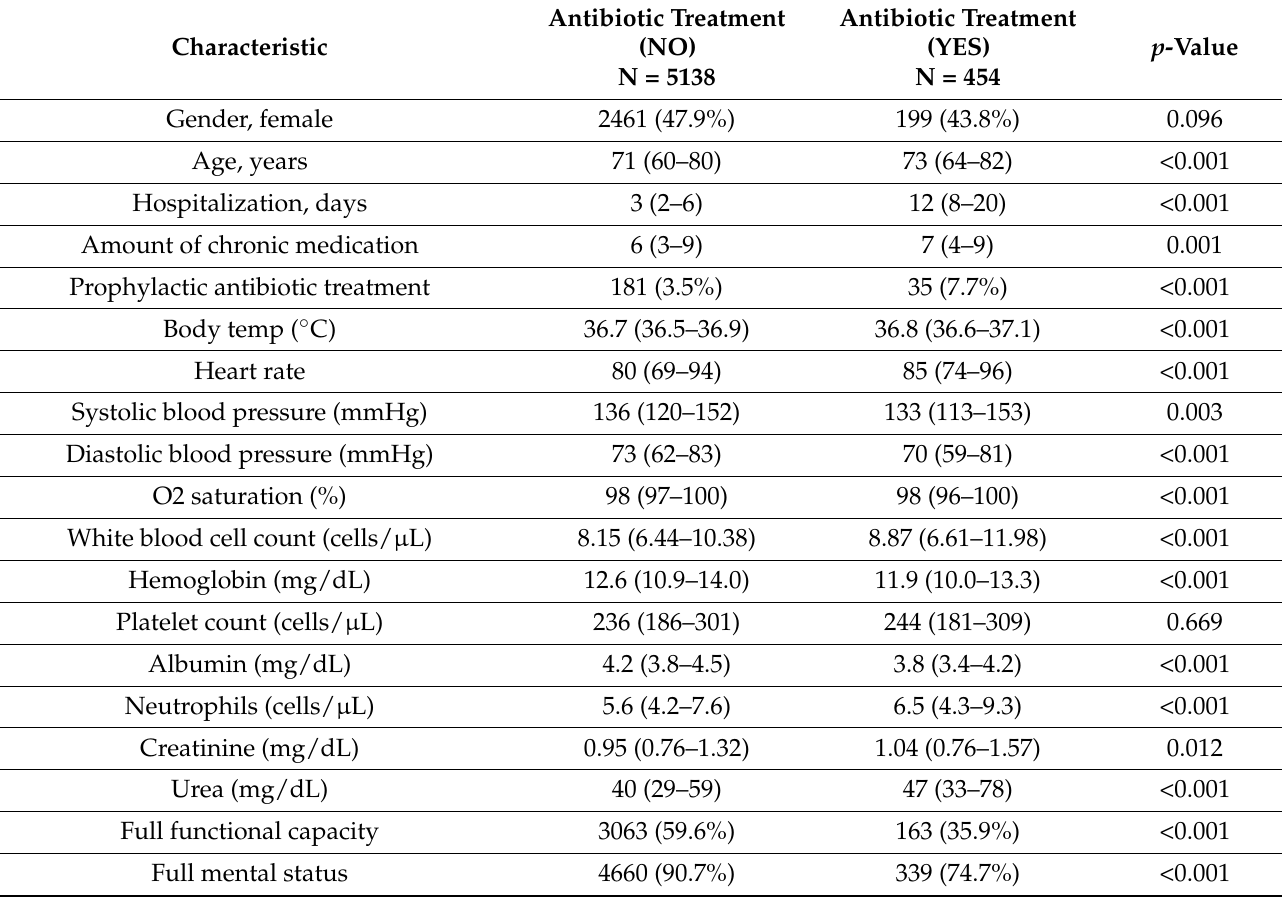
Table 1. Derivation cohort (Beilinson): demographics and underlying disorders of patients with and without antibiotic treatment during